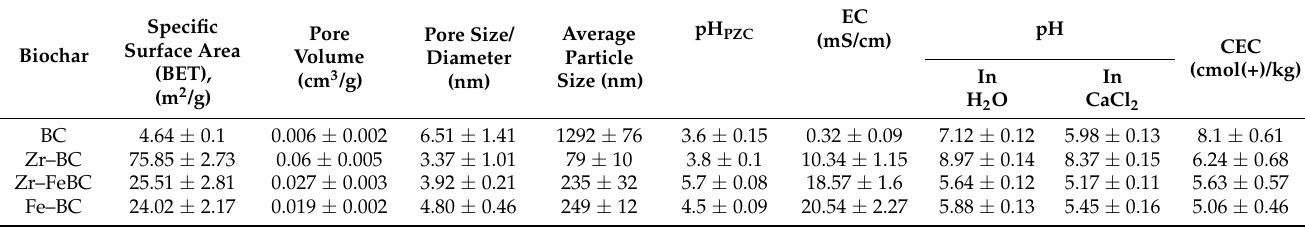
Table 1. Physico-chemical characteristics of